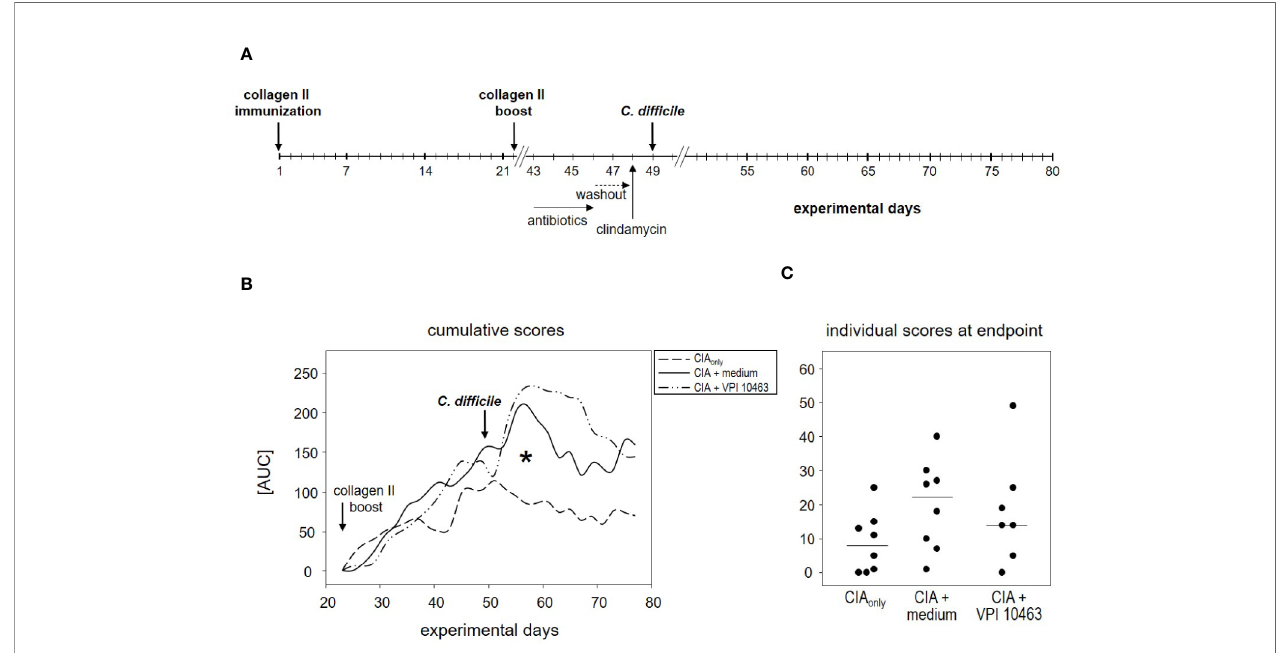
FIGURE 4 | VPI 10463 infection following the onset of collagen-induced arthritis (CIA) lacked therapeutic potential. (A) experimental scheme with CIA induction preceding Clostridioides dif fi cile infection. (B) Cumulative arthritis scores presented as area under the curve (AUC), from experimental day 22 until endpoint. The signi fi cant difference on day 57 was calculated via one-way ANOVA and resulted in a *p-value of 0.0270. (C) Individual arthritis scores at